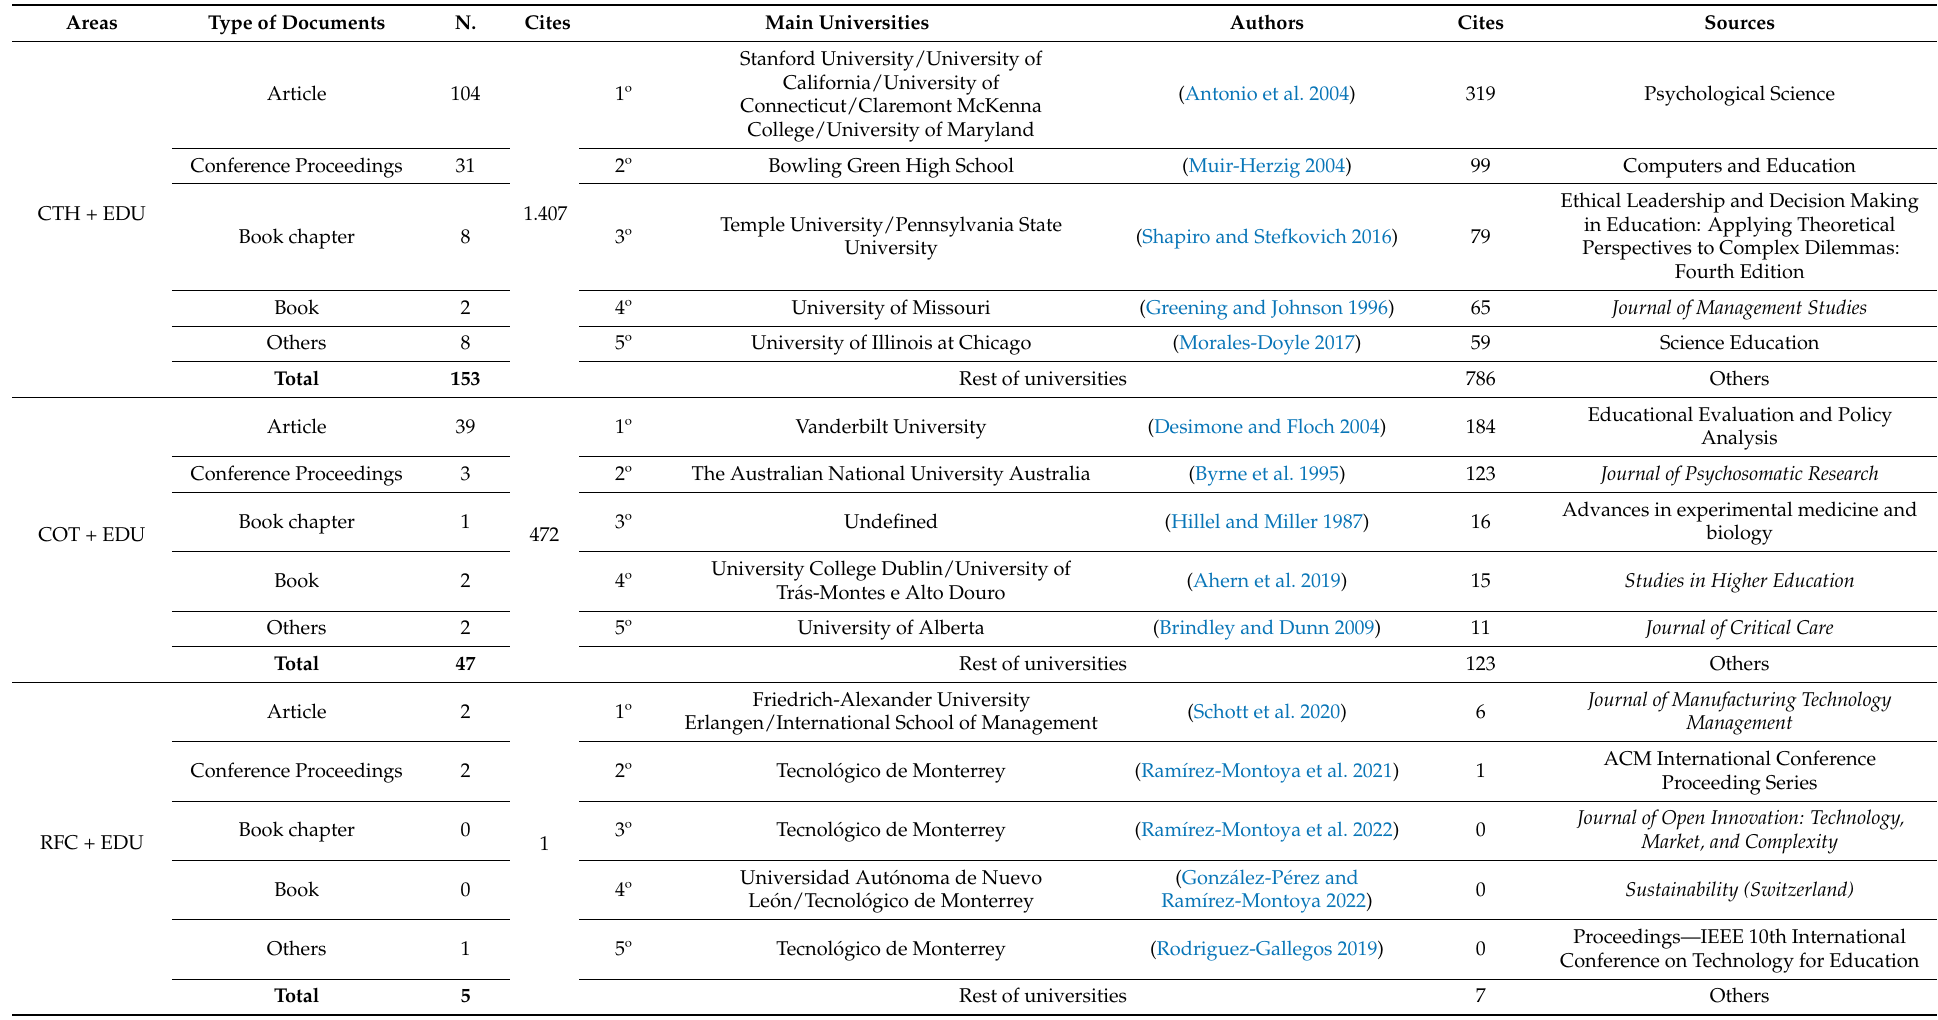
Table 2. Types of publications and other relevant features on complex